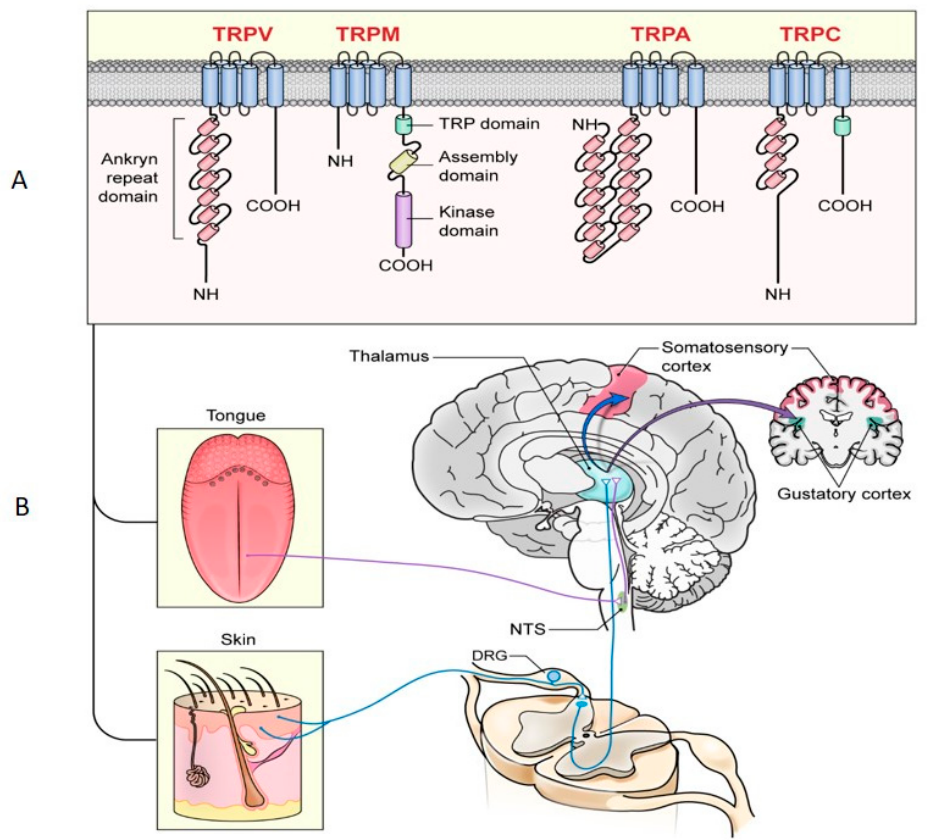
Figure 1. Role of transient receptor potentials (TRPs) in taste and pain sensation: ( A ) TRPs involved in pain and taste perception; ( B ) afferent inputs from nociceptors enter the central nervous system (CNS) via the dorsal root ganglion (DRG) and trigeminal ganglion (TG) for transmission to the cerebral cortex for interpretation. TRPA = transient receptor potential ankyrin; TRPM = transient receptor potential melastatin; TRPV = transient receptor potential vanilloid; TRPC = transient receptor potential-canonical; DRG = dorsal root ganglion; NTS = nucleus tractus solitarius. The blue and purple lines correspond to cranial nerves VII and IX.